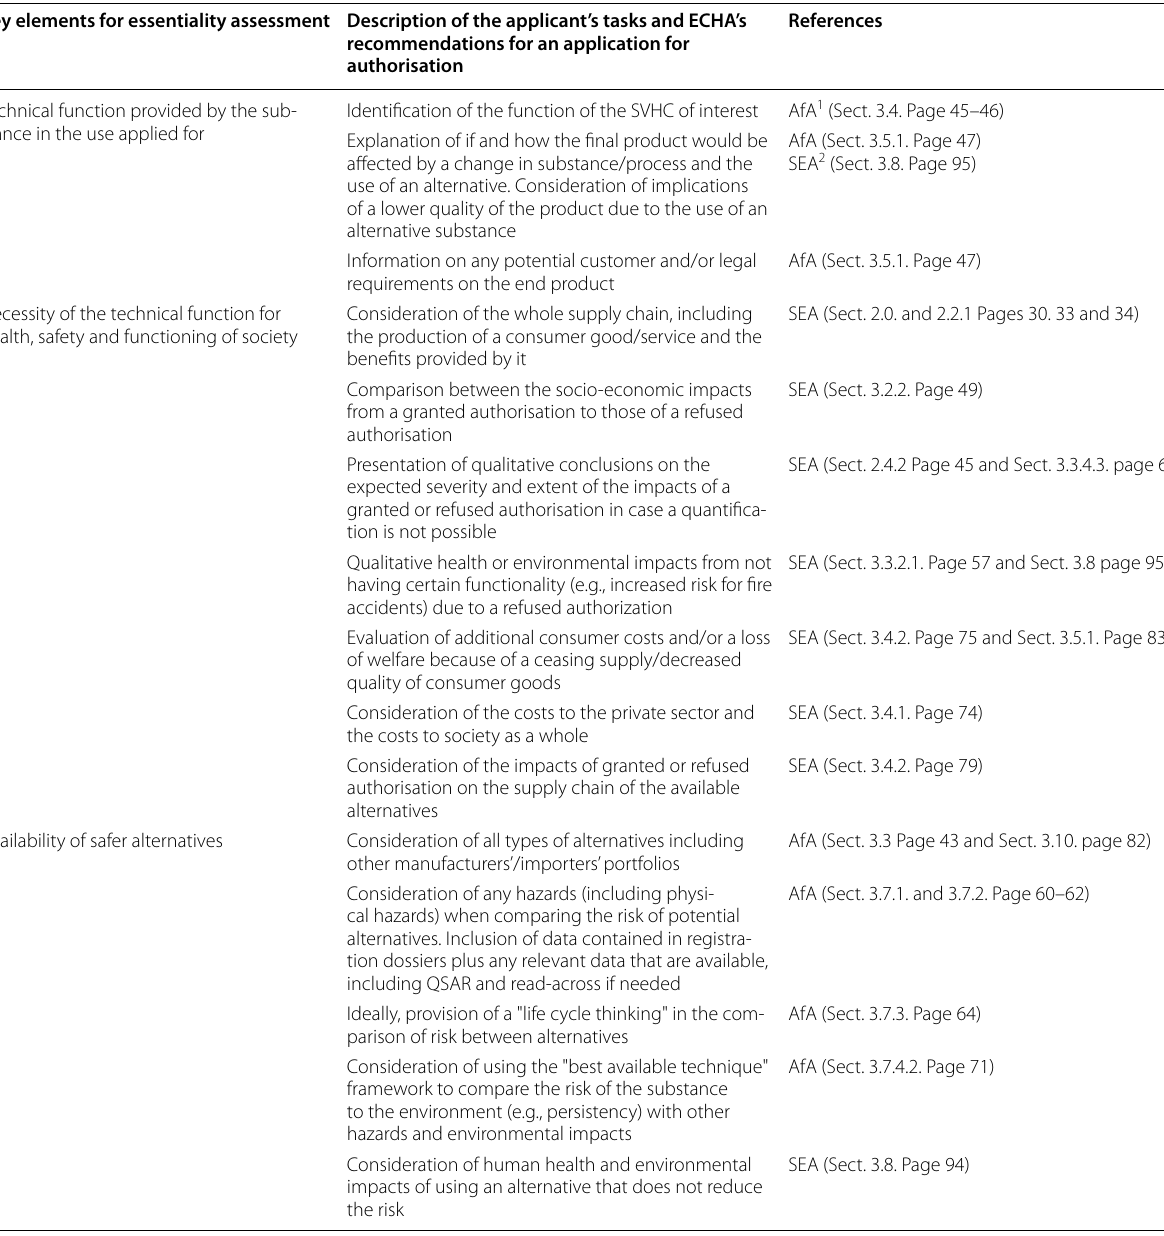
Table 2 Key information useful for an essentiality assessment that should be in an application for